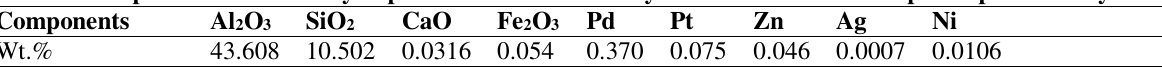
Chemical composition of the catalytic powder as determined by the flame atomic absorption spectrometry.